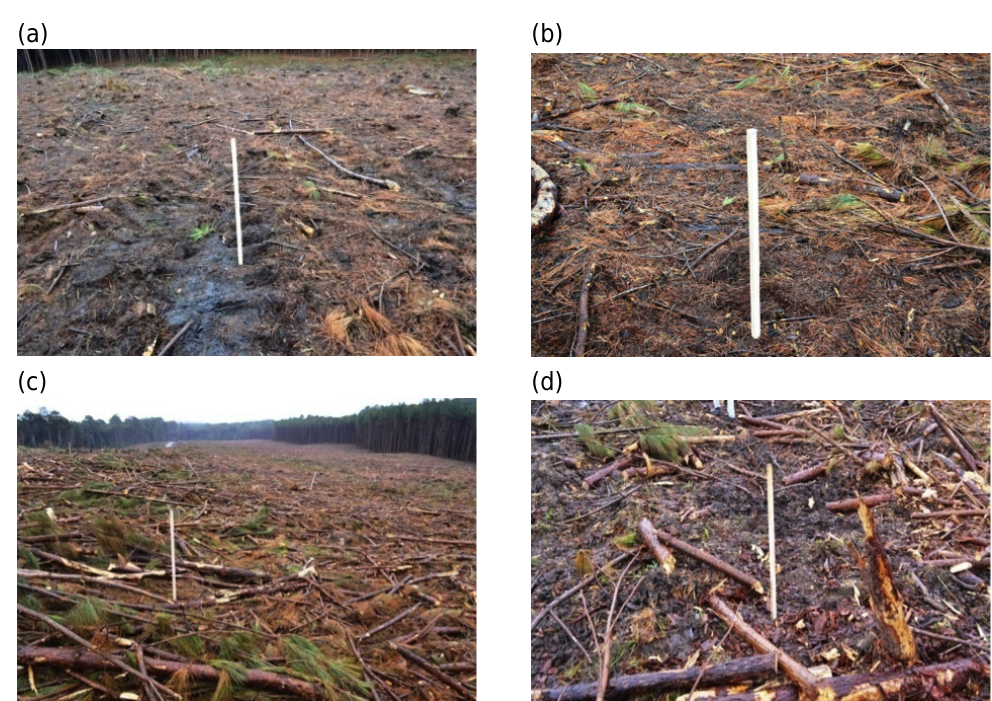
Figure 3. Aspects of areas at post-harvest of high disturbance (a), low disturbance (b), forest residues (c) and log yards